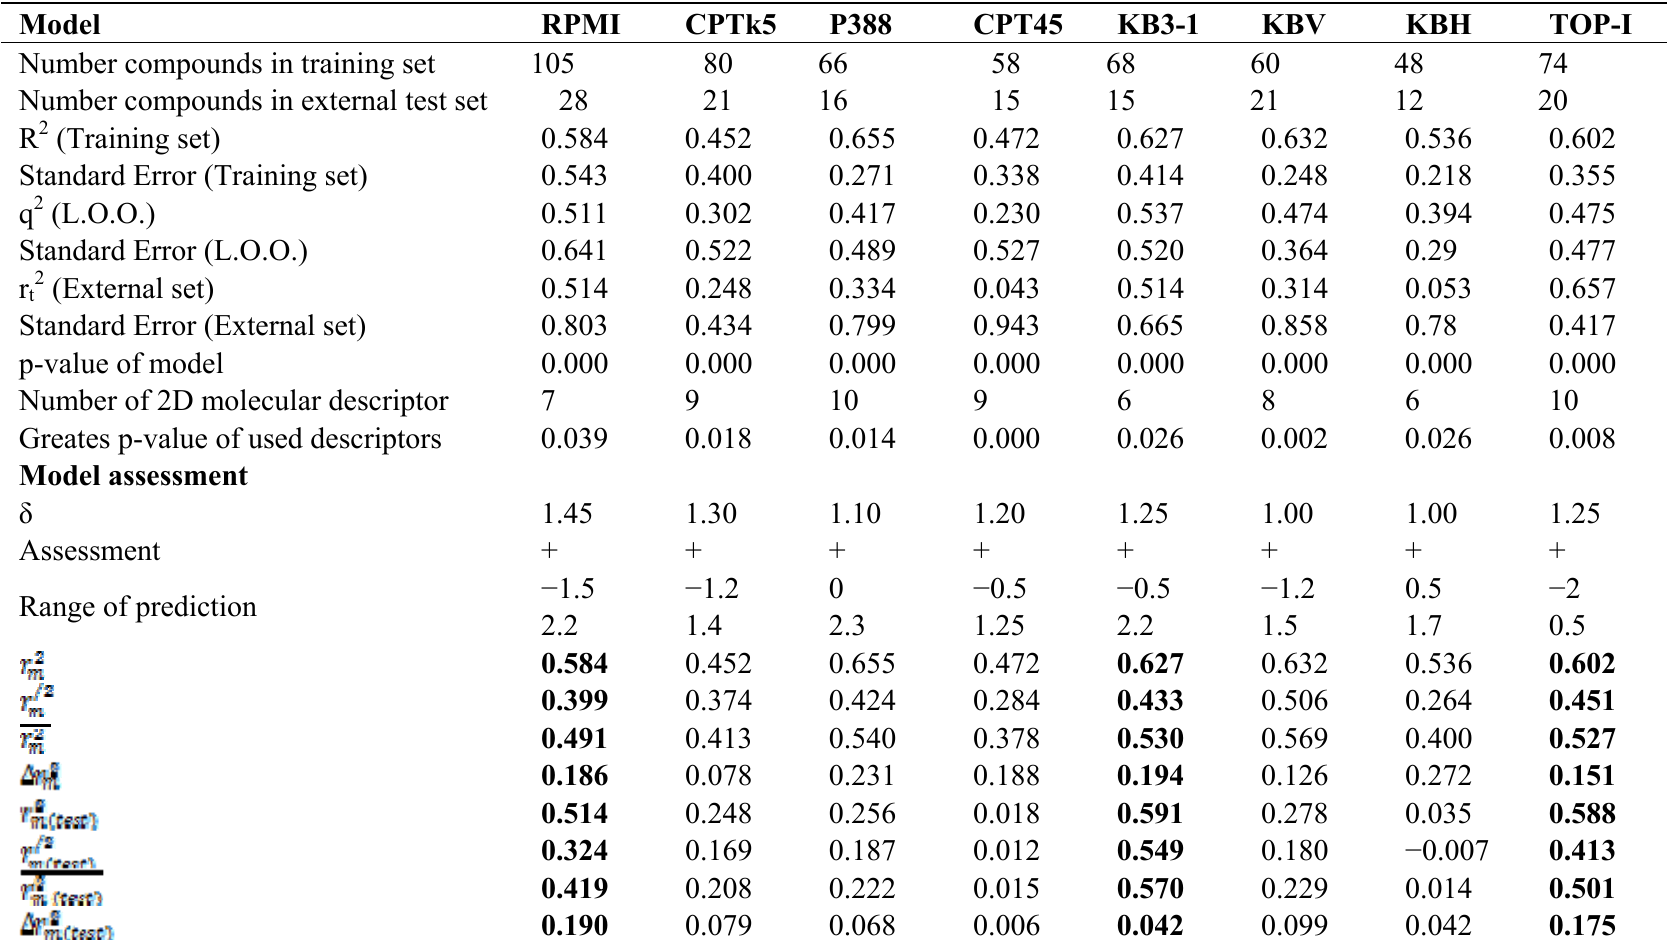
Table 3. Results of